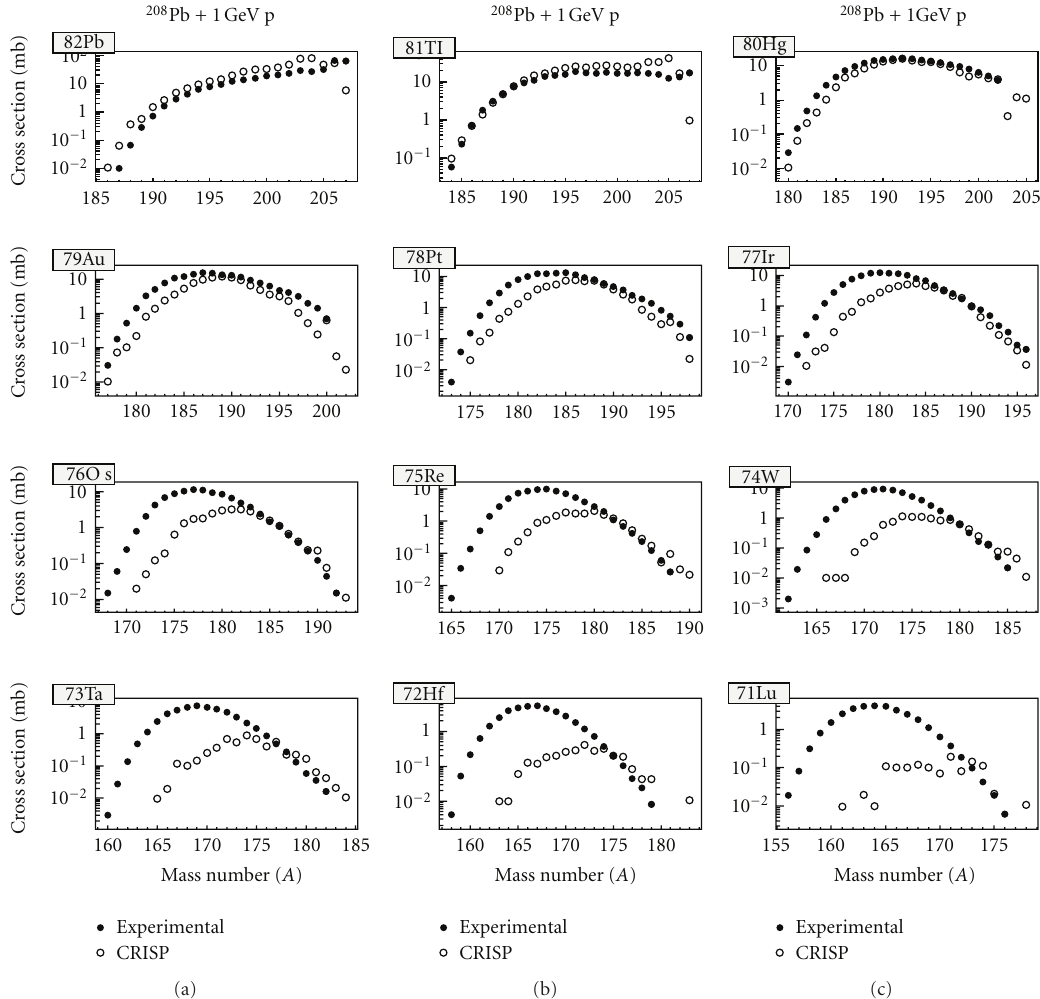
Figure 4: Cross section for fragments produced in spallation of 208 Pb induced by 1GeV